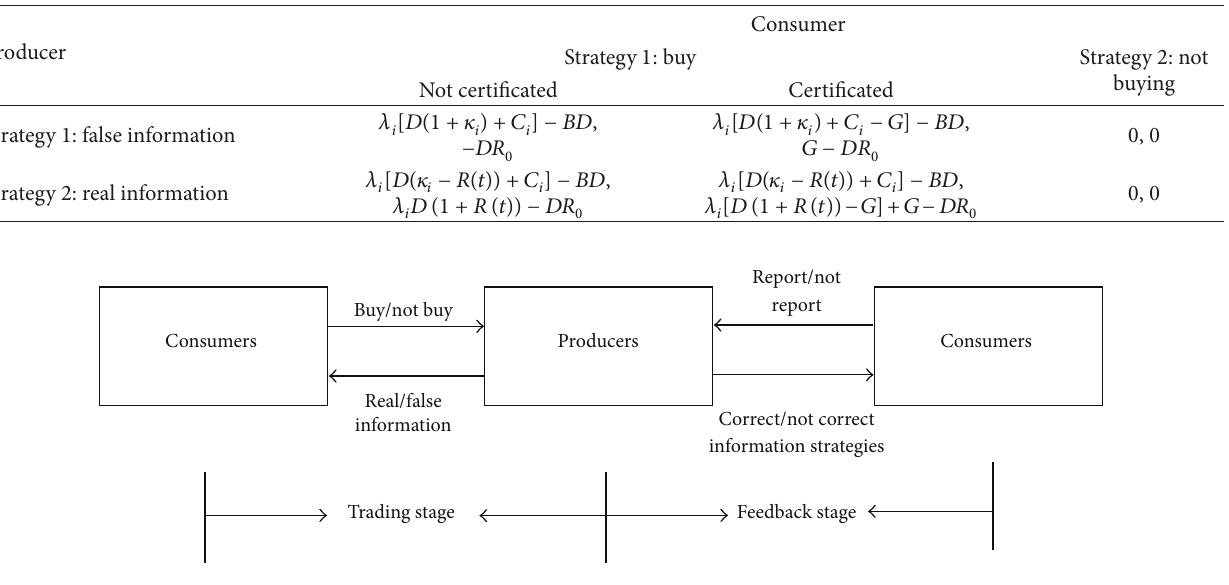
Table 1: Producer-consumer evolutionary game model I.